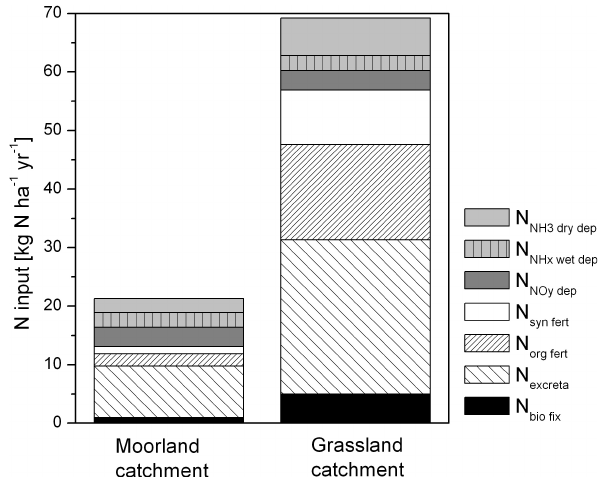
Fig. 2. N inputs (kgNha − 1 yr − 1 ) to the Moorland (left) and the Grassland catchment